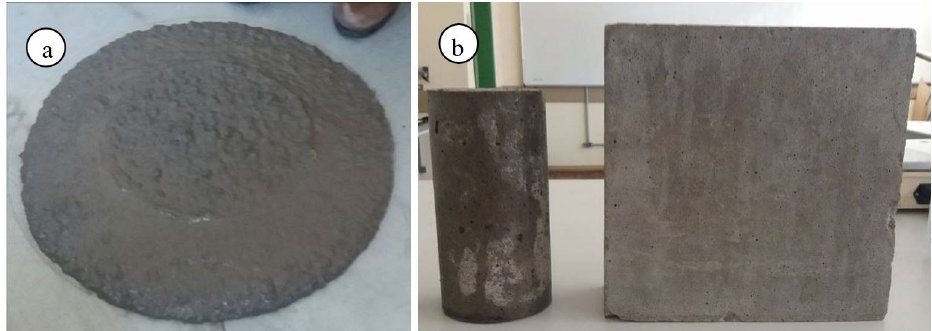
Figure 1. a) Spreading of the concrete in a fresh state and b) types of specimens produced.